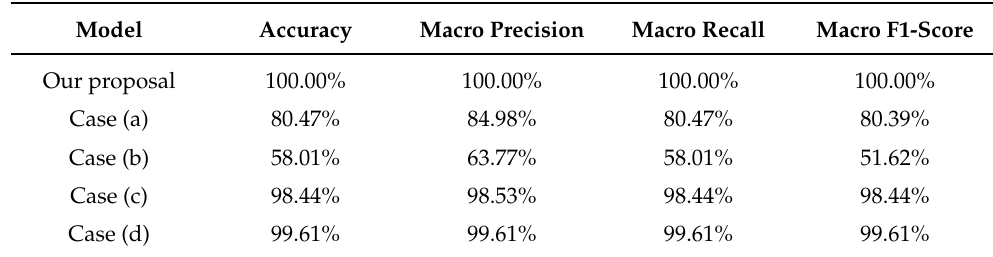
Table 8. Performance metrics comparison of the two models from a macro perspective. The model name indicates how the dataset is